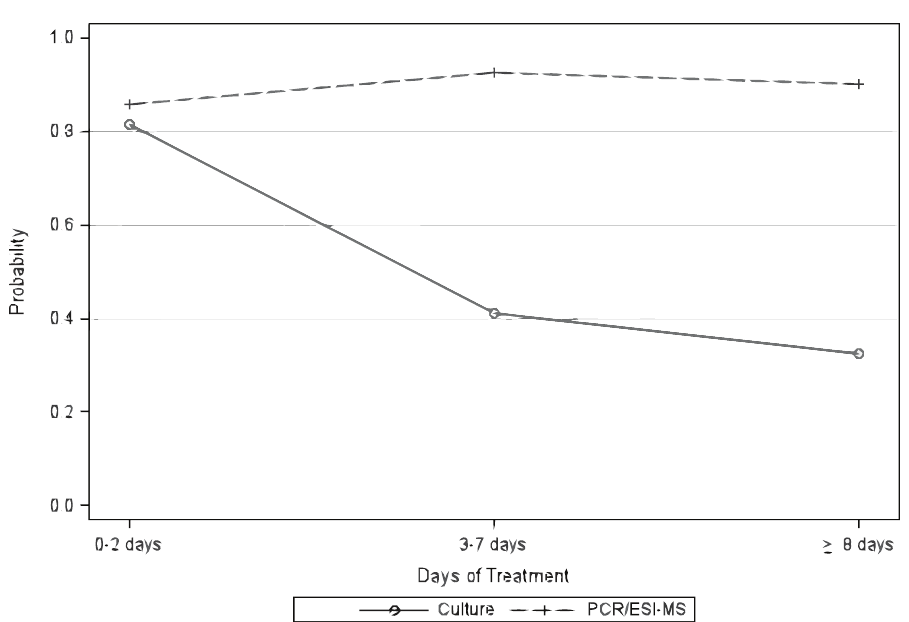
Fig 2. Probability of pathogen detection over time—culture vs. PCR/ESI-MS. Predicted probabilityof pathogen detection for culture vs. PCR/ESI-MS for sterile specimens obtainedat DOT (cid:20) 2, DOT 3–7 and DOT (cid:21)